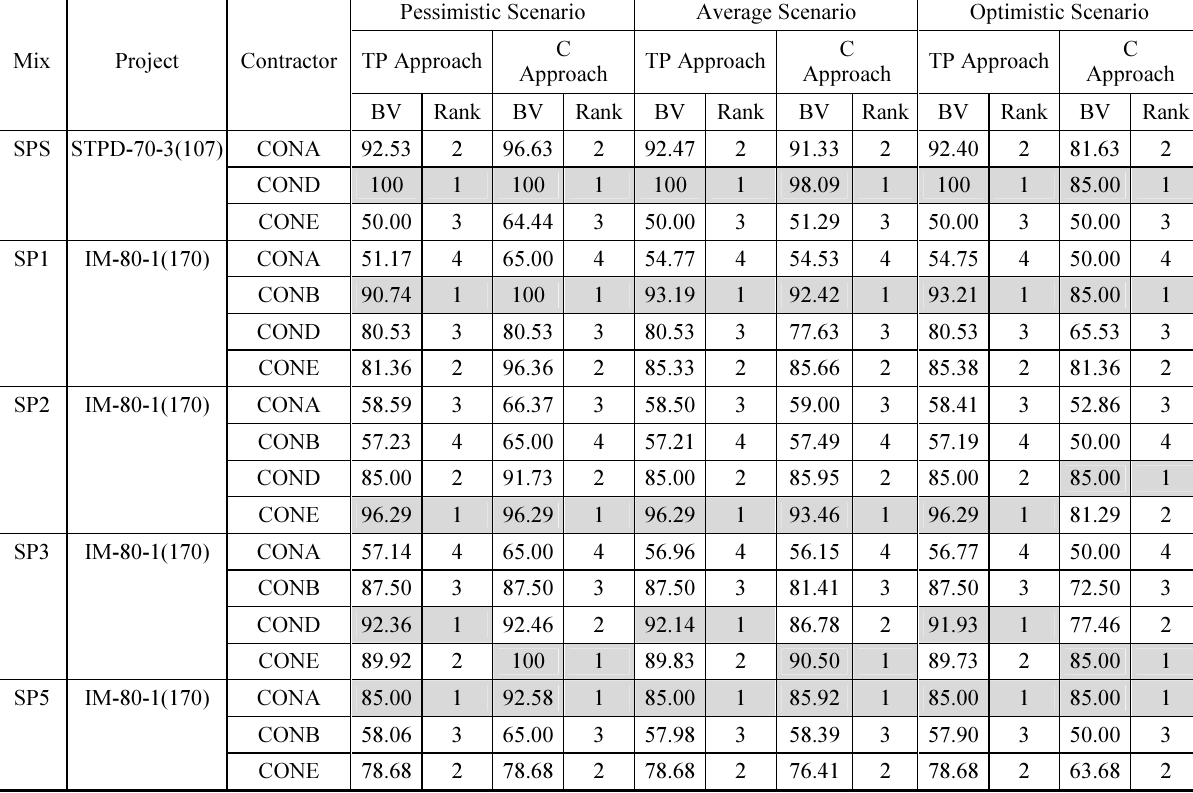
Table 4. Summary of contractor’s BV and ranking for different SP mixes